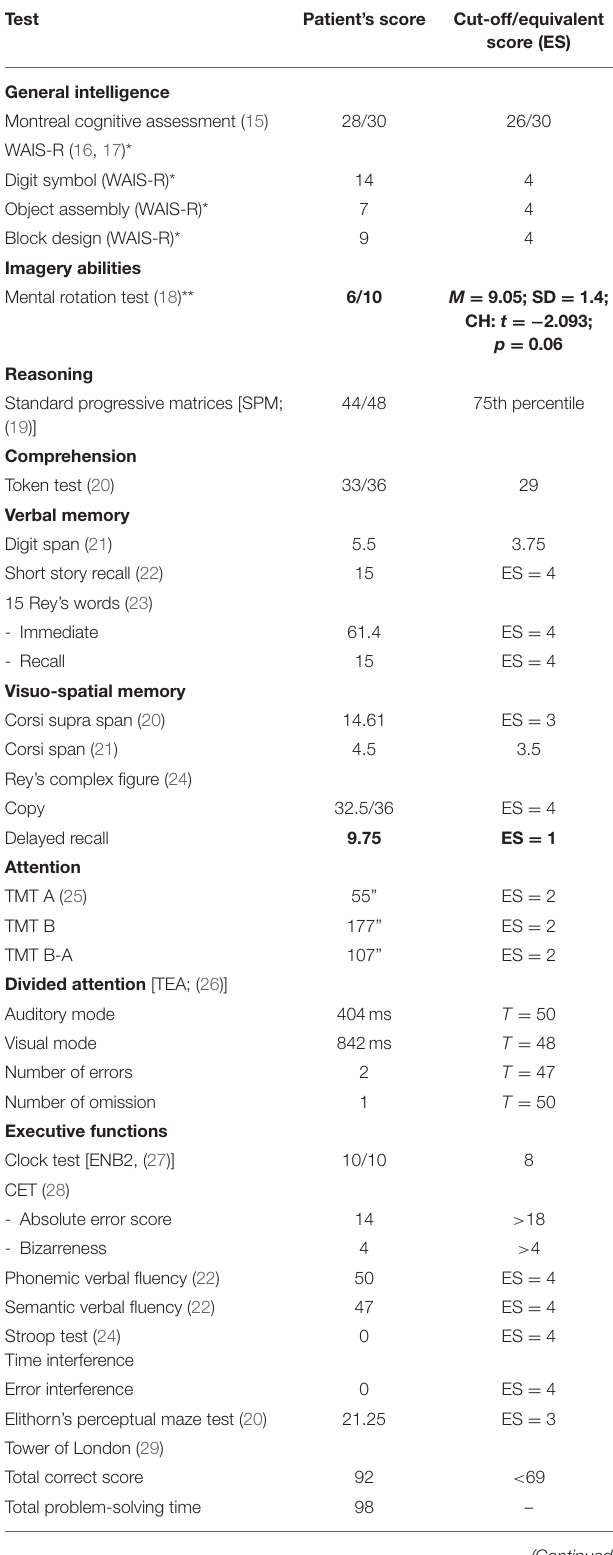
TABLE 1 | Results of LISA’s first neuropsychological assessment (13 years of